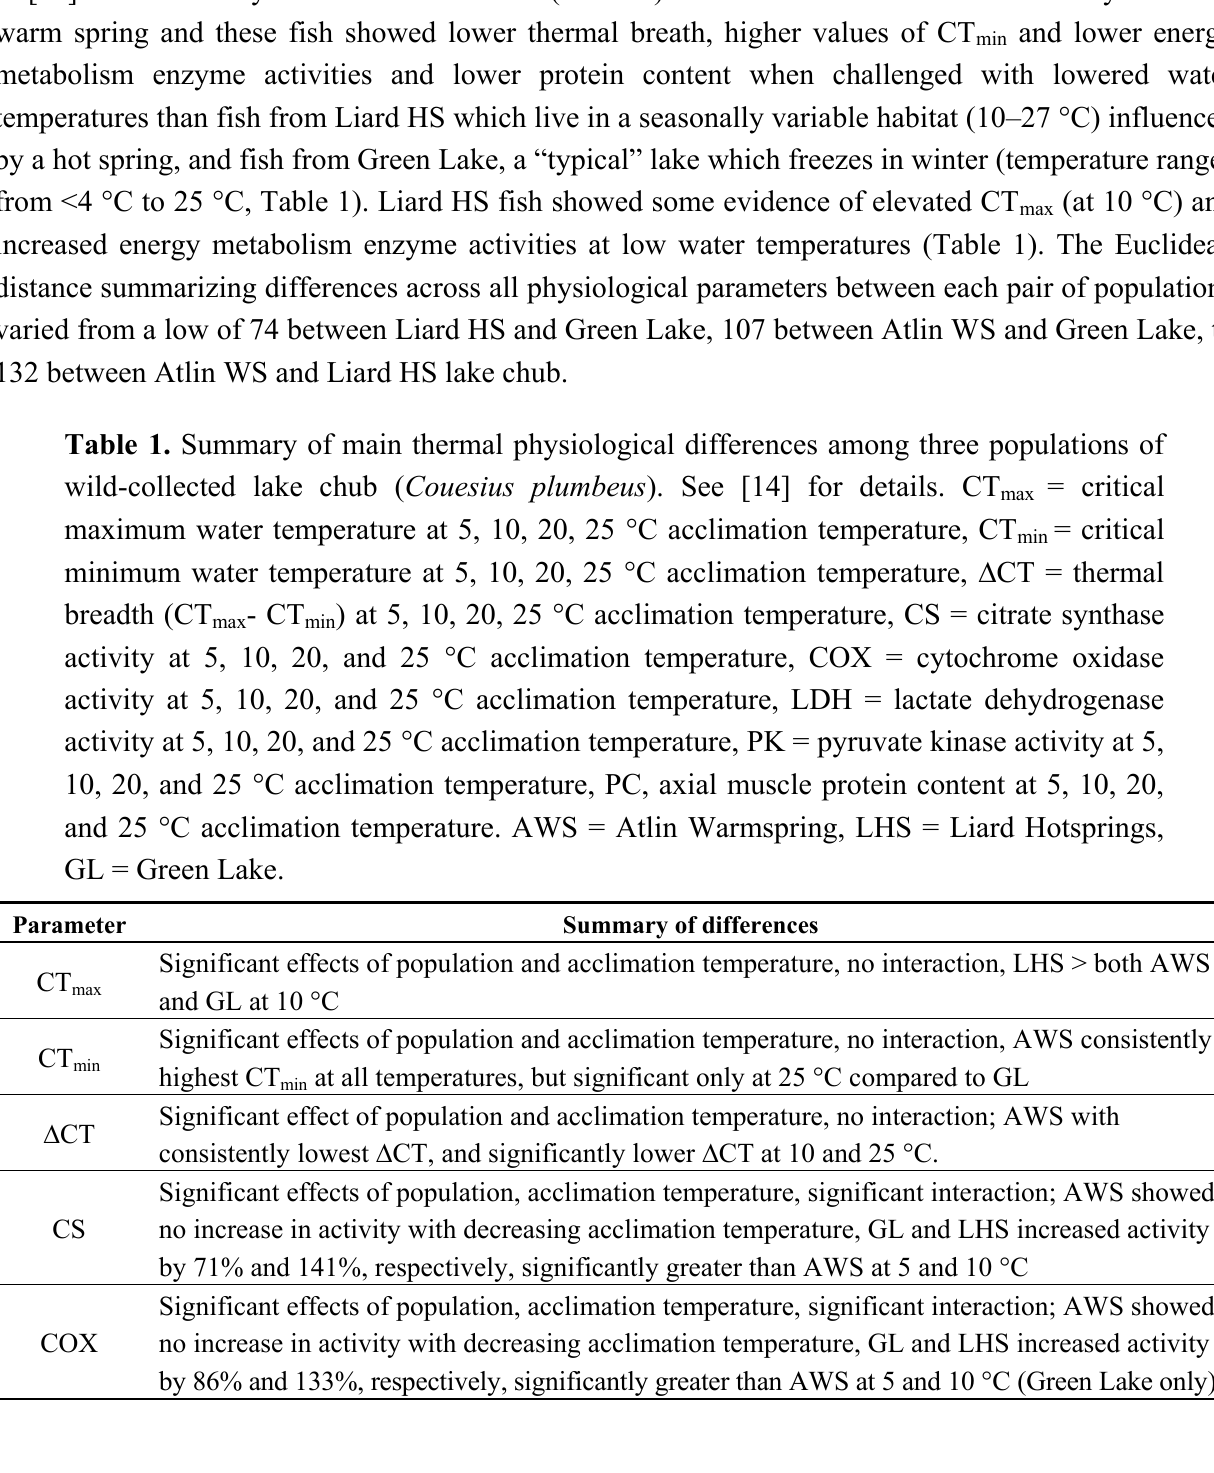
= critical max = critical min